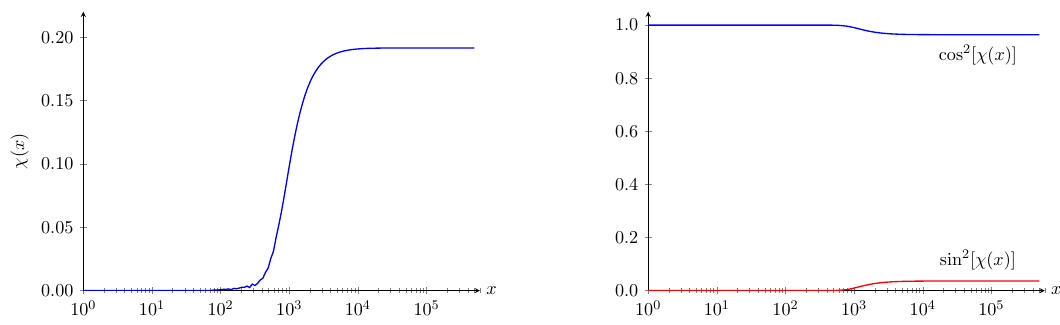
Figure 1 . Evolution of (cid:31) ( x ) (left panel) and cos 2 [ (cid:31) ( x )] and sin 2 [ (cid:31) ( x )] (right panel, blue and red curve respectively) as a function of the dimensionless distance x from the magnetar surface for the benchmark point ! = 100 keV, m a = 10 (cid:0) 8 keV, g = 10 (cid:0) 15 keV (cid:0) 1 , r 0 = 10 km, B 0 = 20 and (cid:18) = (cid:25)=